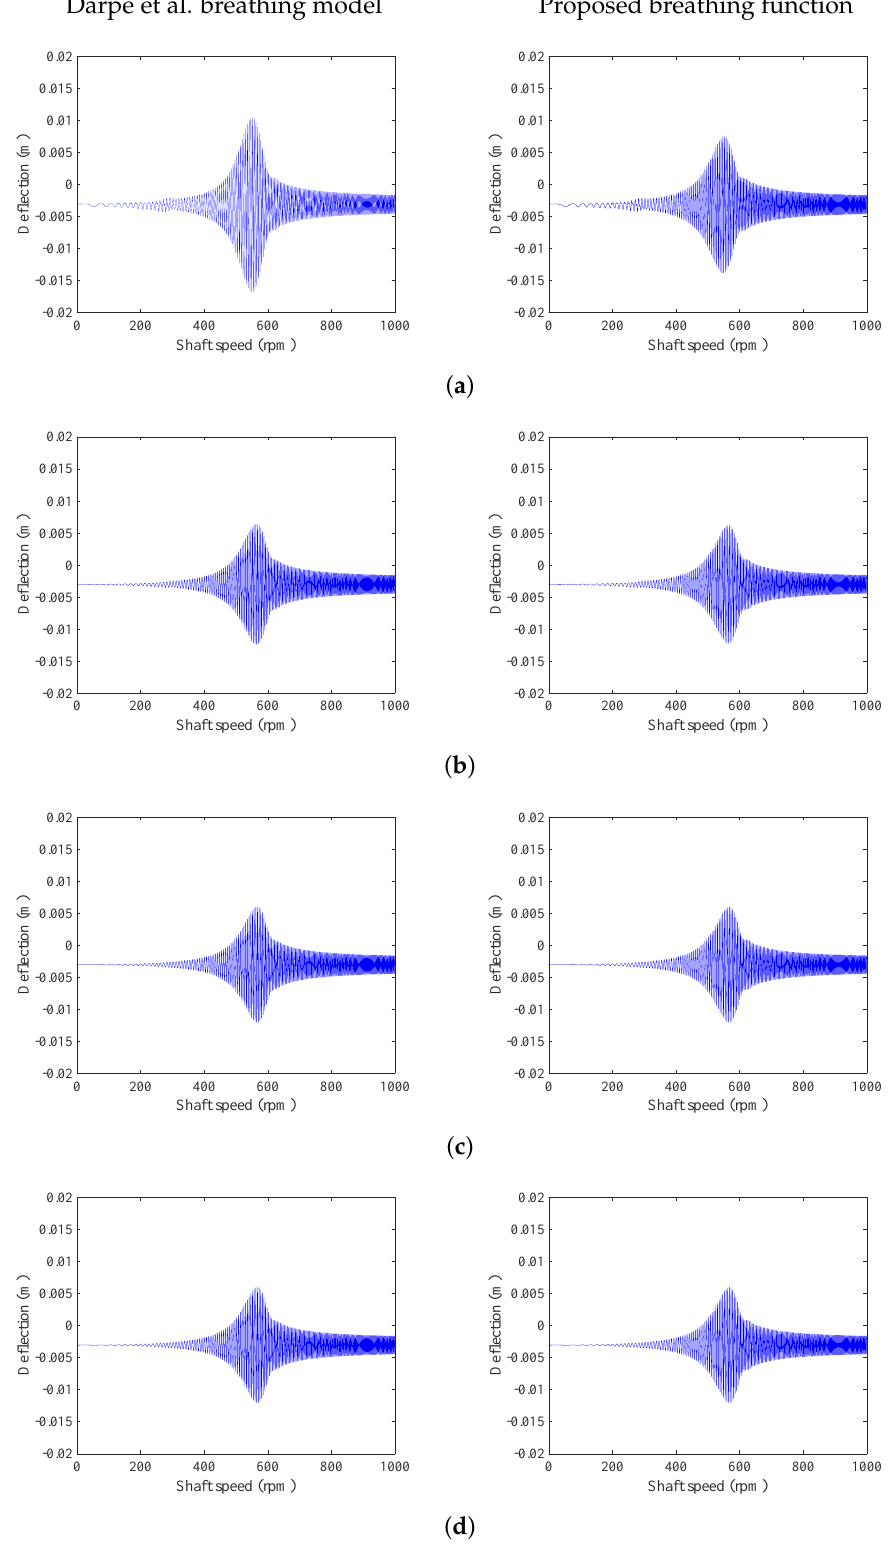
Figure 8. Vertical transient response of the Jeffcott rotor system with normalized crack depths of ( a ) µ = 1; ( b ) µ = 0.5; ( c ) µ = 0.2; and ( d ) µ = 0.1 using the Darpe et al. [4] breathing model and alternate breathing function (softly clipped cosine